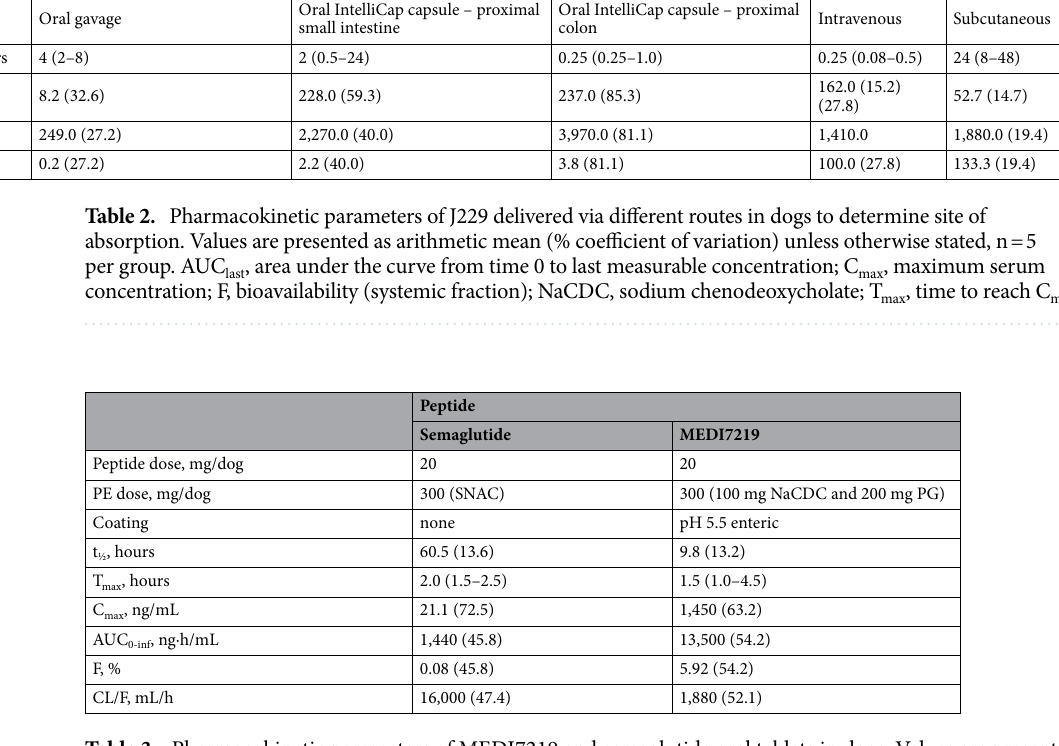
Table 3. Pharmacokinetic parameters of MEDI7219 and semaglutide oral tablets in dogs. Values are presented as arithmetic mean (% coefficient of variation), except T max shown as median and range (min–max), n = 9 per group. AUC 0-inf , area under the curve from time 0 to infinity; CL/F, oral clearance; C max , maximum serum concentration; F, bioavailability (systemic fraction); NaCDC, sodium chenodeoxycholate; PE,